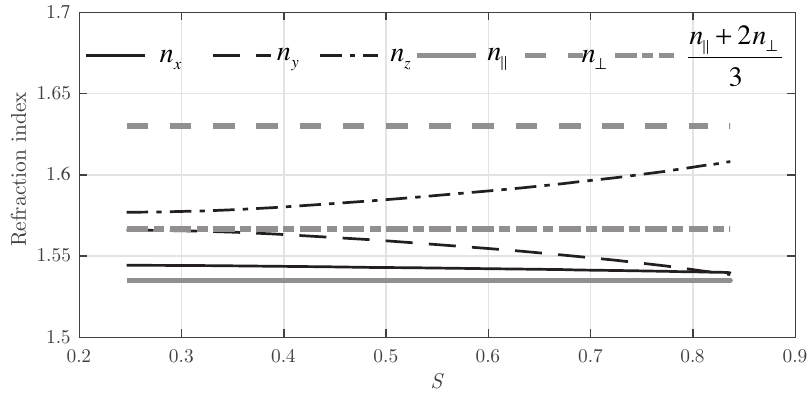
Figure 5. Evolution of the refractive index for the x , y and z components as a function of S for Grating #1.